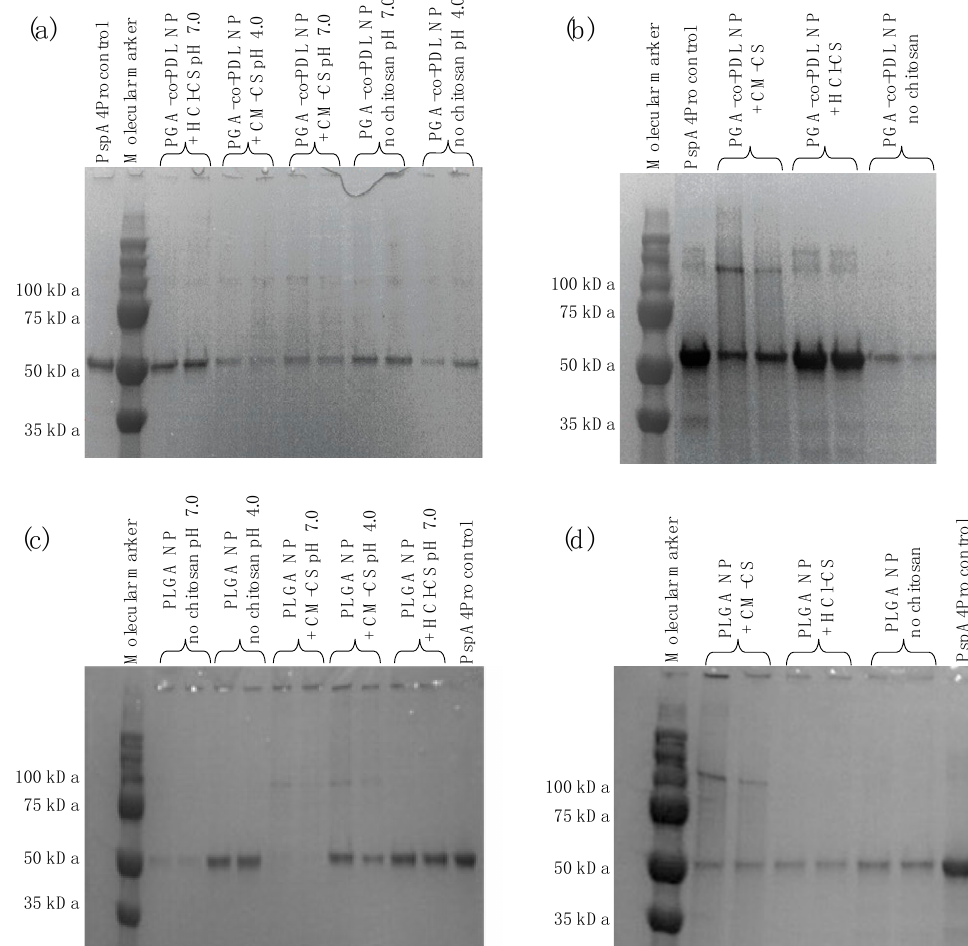
Figure 4. SDS-PAGE of PspA4Pro released from PGA-co-PDL or PLGA NPs. ( a ) PGA-co-PDL NPs carrying surface-adsorbed PspA4Pro prepared by o / w single emulsion. ( b ) PGA-co-PDL NPs prepared at pH 7.0 by w / o / w double emulsion with encapsulated PspA4Pro. ( c ) PLGA NPs carrying surface-adsorbed PspA4Pro prepared by o / w single emulsion. ( d ) PLGA NPs prepared at pH 7.0 by w / o / w double emulsion with encapsulated PspA4Pro.